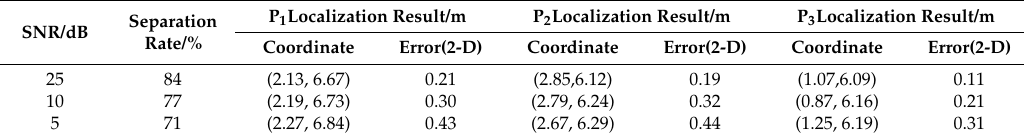
Table 5. The separation and localization results using previously reported method at different